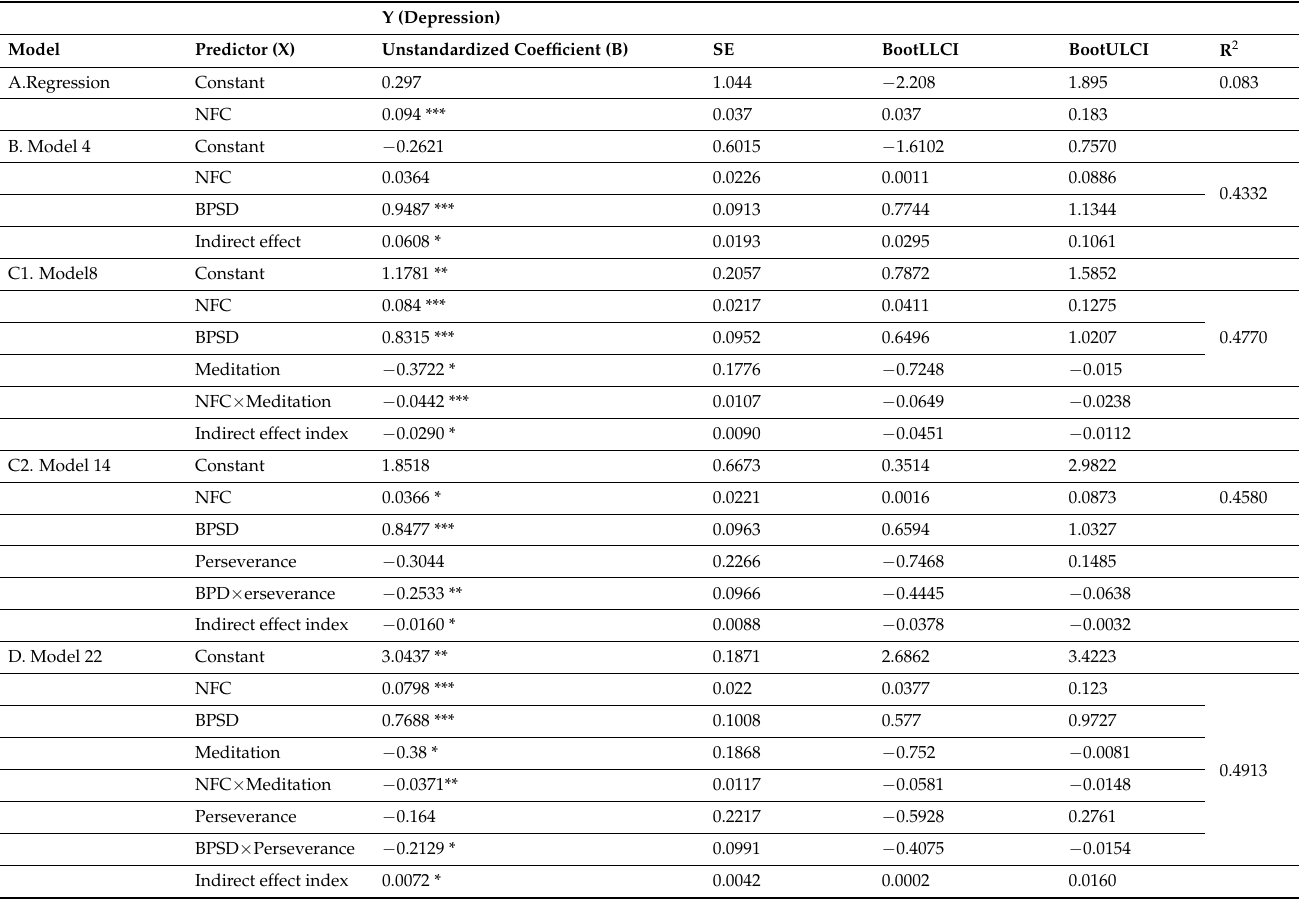
Table 3. Summary of moderated mediation analysis of NFC, meditation and perseverance predict- ing depression. Y